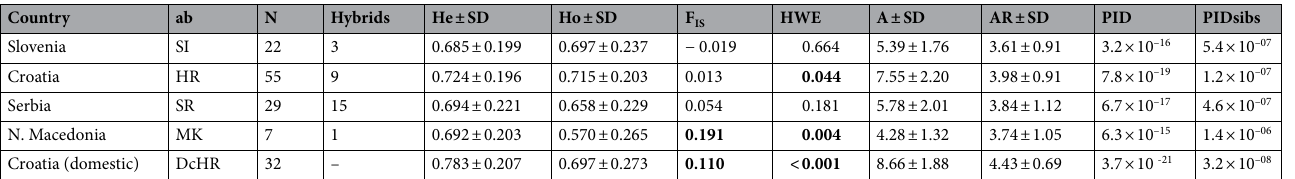
Table 1. Genetic diversity among European wildcat populations in the area between the Dinaric Alps and the Scardo-Pindic Mts. based on 18 microsatellite loci. Standard deviations are for average values; P < 0.05 for HWE and F IS (before Bonferroni correction) is indicated in bold He expected heterozygosity, Ho observed heterozygosity, F IS inbreeding coefficient, HWE Hardy–Weinberg equilibrium, A number of alleles, AR allelic richness (calculated by the rarefaction method for the lowest sample size n = 10), PID: